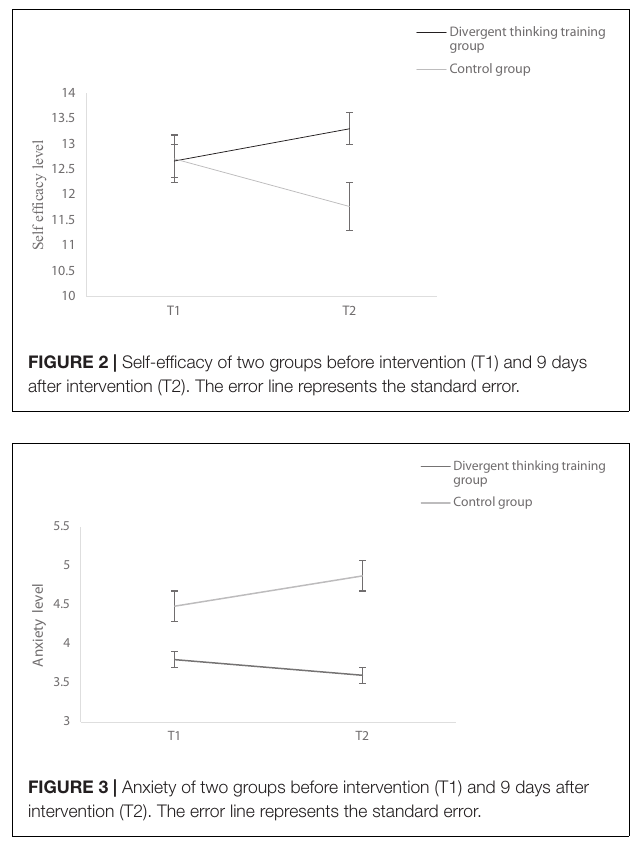
F (1,55) = 1.062, p = 0.307, which confirmed the results of the repeated measurement analysis of